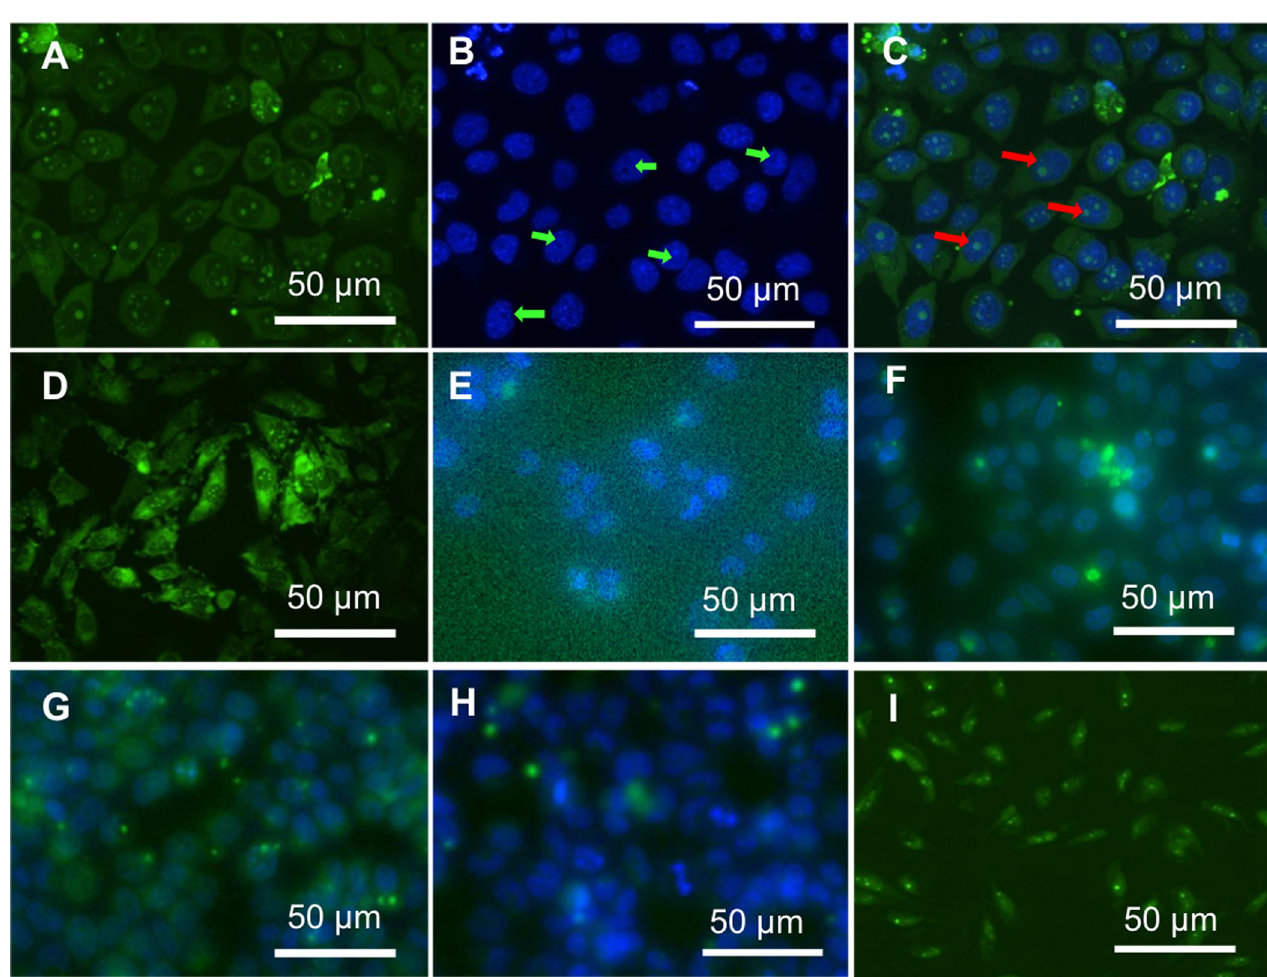
Fig 4. The fluorescent image of HeLa cells incubated with carbon dots from CA: EDA 1:2 and Hoechst 33342, (A) for blue bright excitation, (B) for UV bright excitation, (C) for overlap of (A) and (B). Fluorescent image of the HeLa cells stained with SYTO RNA-select green fluorescent dye (D). The fluorescent images of HeLa cell incubated with 400 μ g/mL of carbon dots made from CA (E), EDA (F), and CA and PEI with CA: EDA 1:0.5 (G) and 1:2 (H) for 24 h. The fluorescent images of LN229 incubated with 400 μ g/mL of carbon dots for 4 h (I).